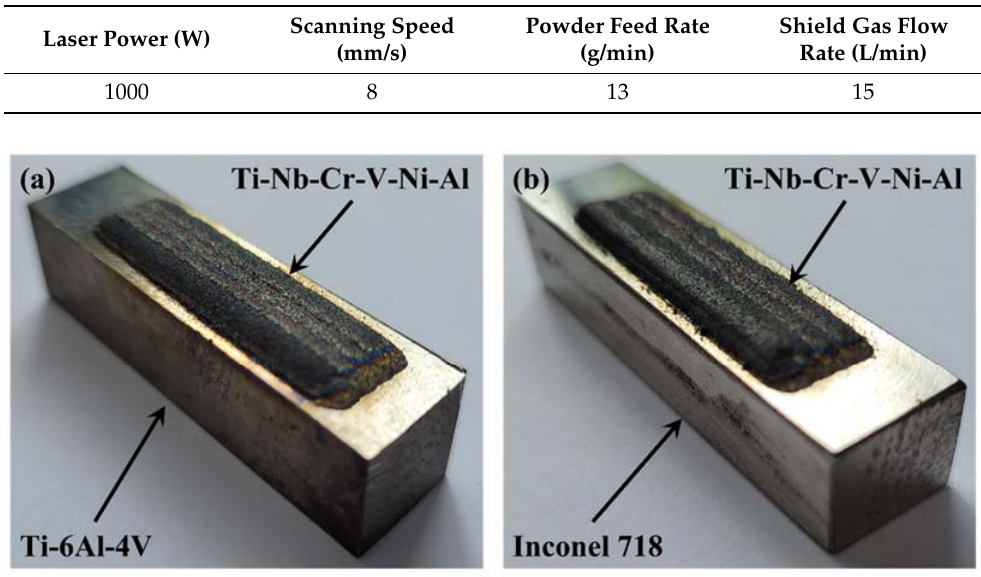
Figure 5. The schematic diagram of the overlapping efficiency. Table 3. The DED conditions.